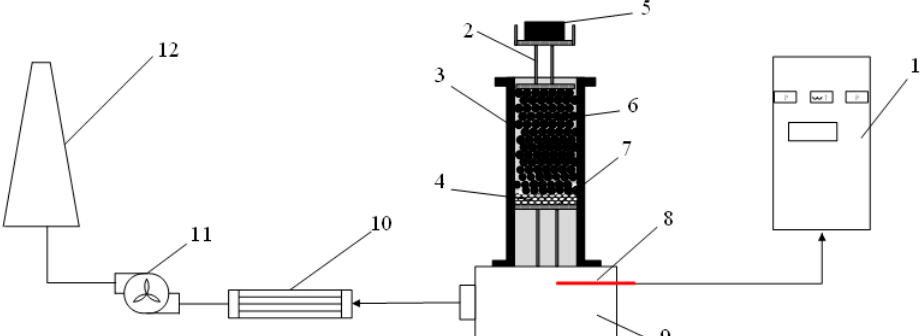
Figure 2. Schematic diagram of the pressurized densification sintering process of limonitic nickel laterite in sinter pot tests (1—control cabinet, 2—pressure device, 3—sinter pot, 4—hearth layer, 5—pressurized weight, 6—sinter bed, 7—bar grate, 8—thermocouple, 9—vacuum chamber, 10—condenser tube, 11—air blower, 12—chimney).